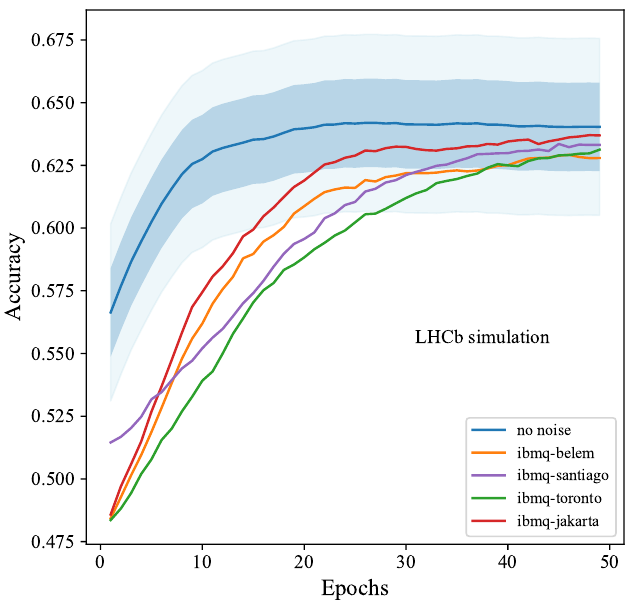
Figure 12. Validation accuracy for noise models as a function of the number of epochs. Blue (light-blue) band represent 1 σ ( 2 σ ) uncertainty bounds for the noiseless